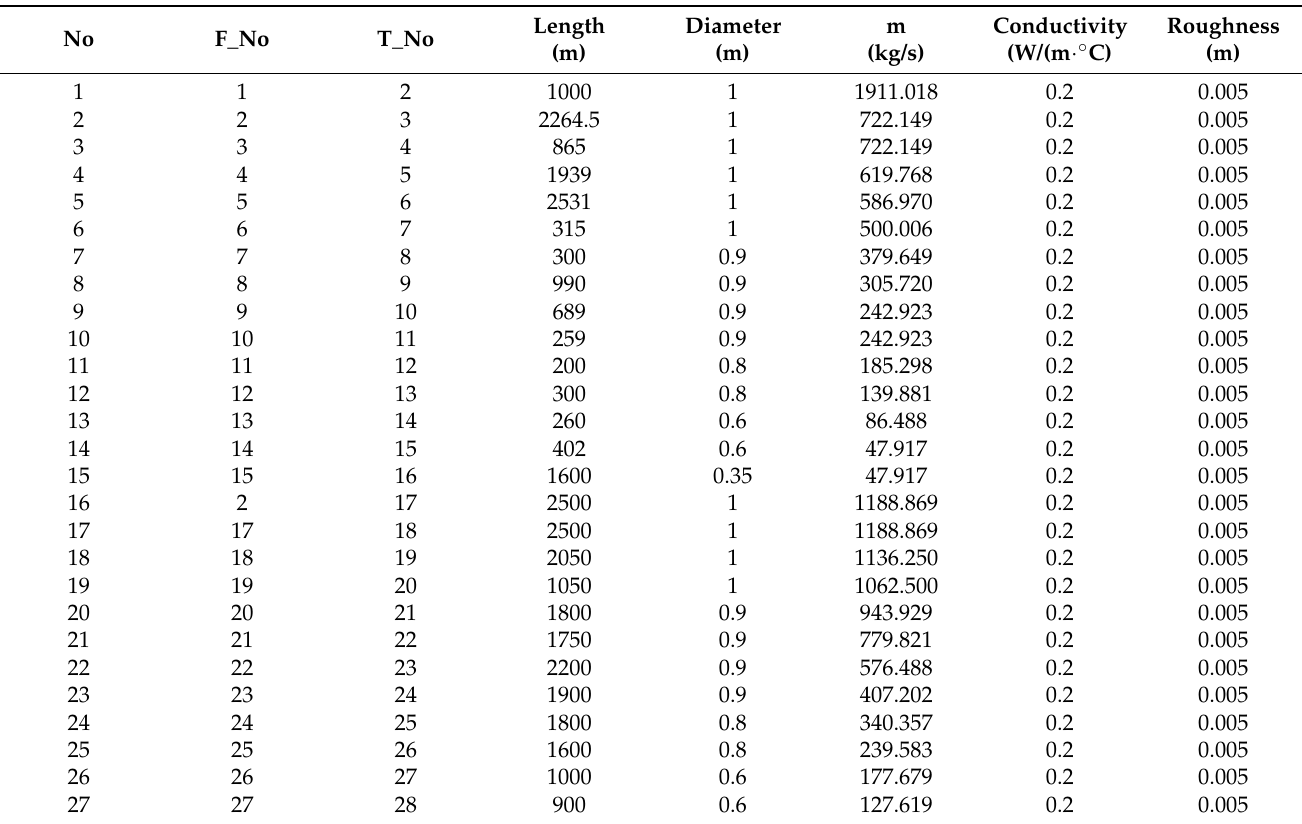
Table A2. Heat network pipe